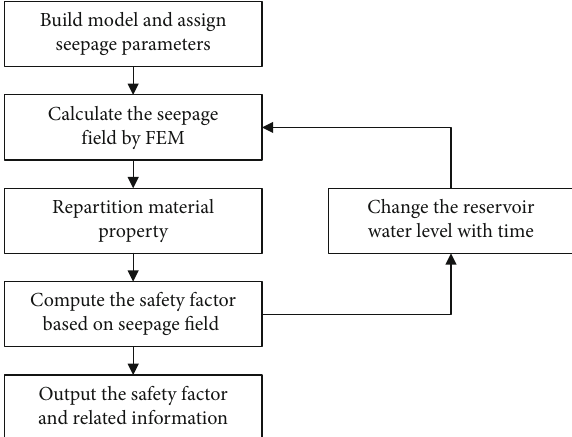
Figure 3: Flow chart for the calculation of the slope with reservoir level fl